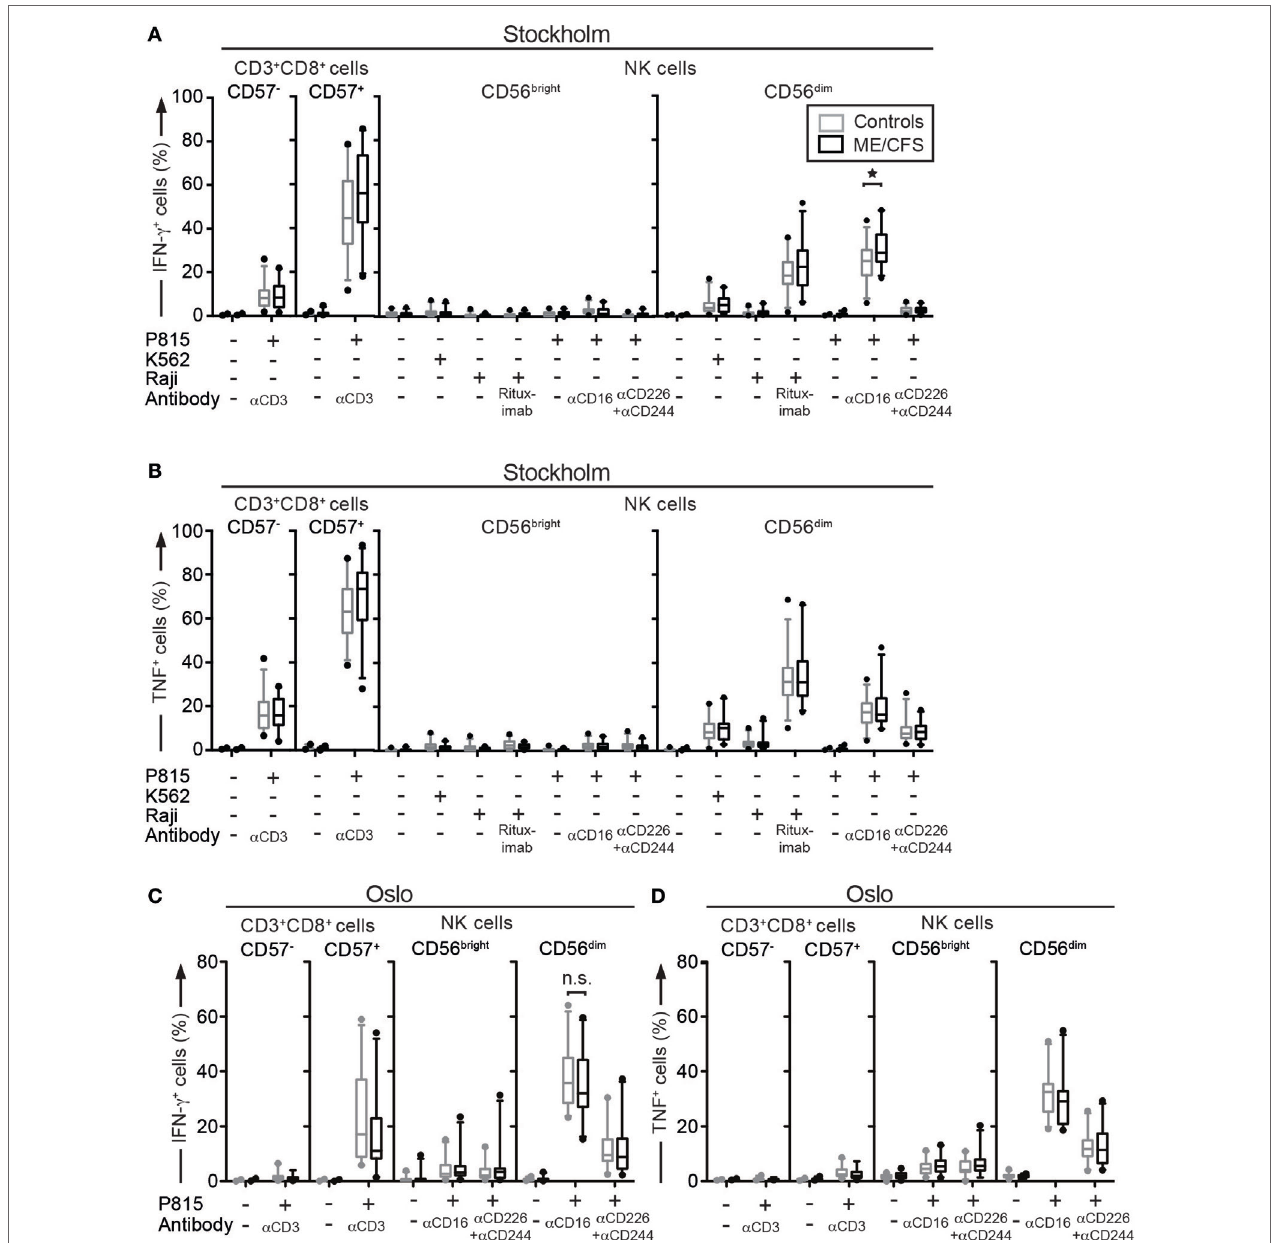
FigUre 3 | Pro-inflammatory cytokine production is similar between ME/CFS patients and controls. (a–D) Analysis of cytokine production. Peripheral blood mononuclear cells were thawed, rested overnight, and then stimulated for 4 h with no target, P815 + anti-CD3, K562, Raji, Raji + Rituximab, P815, P815 + anti- CD16, P815 + anti-CD244 + anti-CD226 (DNAM-1), and subsequently stained with antibodies to lineage markers, fixed, permeabilized, and stained intracellularly for IFN- γ and TNF. (a) Percentage of four CD8 + T cell and natural killer (NK) cell subsets positive for IFN- γ in the Stockholm substudy. (b) Percentage of four CD8 + T cell and NK cell subsets positive for TNF in the Stockholm substudy. (c) Percentage of four CD8 + T cell and NK cell subsets positive for IFN- γ in the Oslo substudy. (D) Percentage of four CD8 + T cell and NK cell subsets positive for TNF in the Oslo substudy. Gray boxes depict control values, whereas black boxes depict patient values. Lines through boxes show the median. Error bars extend to 5th and 95th percentile. Dots show outliers. 24 patients and 28 controls and 22 patients and 24 controls for the Stockholm and Oslo substudies, respectively, are included in the